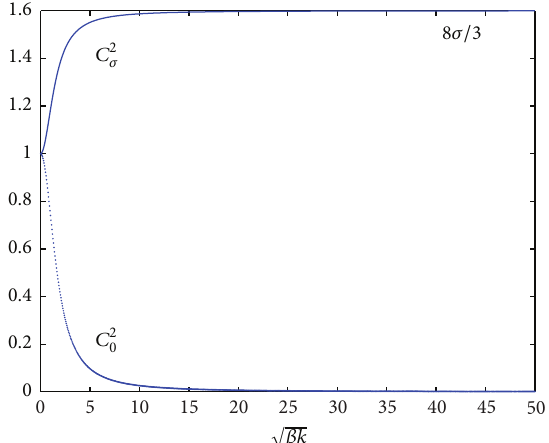
Figure 13: The phase velocity for system (75).